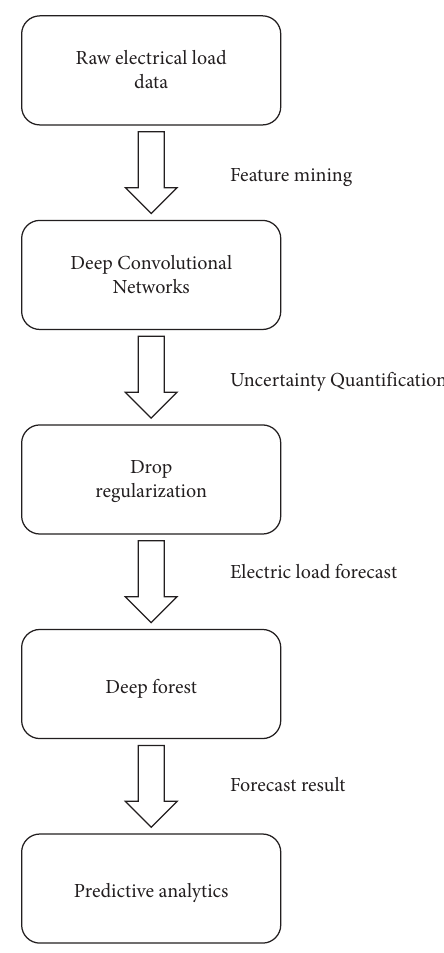
Figure 2: A new method for accurate prediction of power